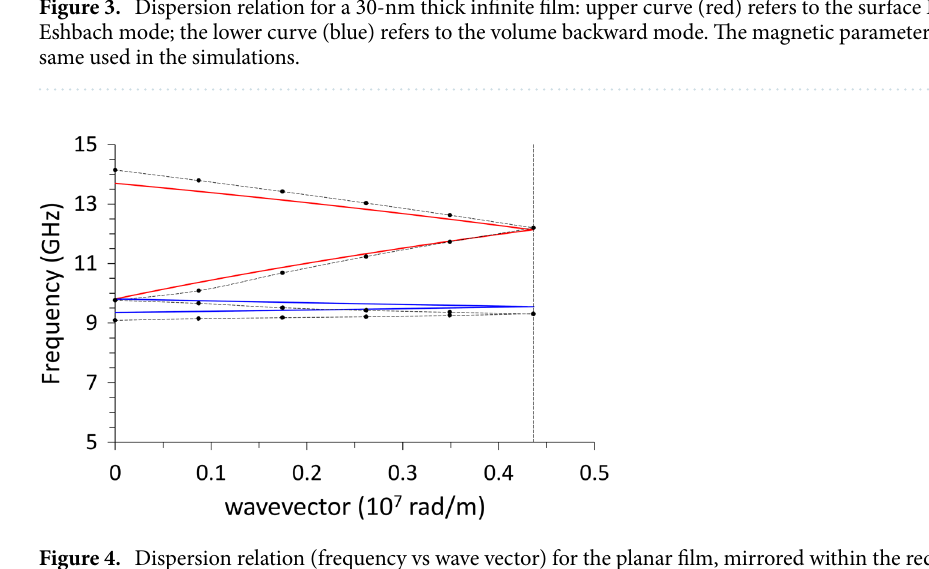
Figure 4. Dispersion relation (frequency vs wave vector) for the planar film, mirrored within the reduced Brillouin zone: analytical solutions (solid lines) and DMM results (symbols, dashed lines are guides for the eyes). The red curve refers to the surface Damon-Eshbach mode; the blue curve refers to the volume backward mode. The vertical dashed line, at k = 4.36 × 10 7 rad/m is the virtual zone boundary if the primitive cell lenth was the one in Fig.